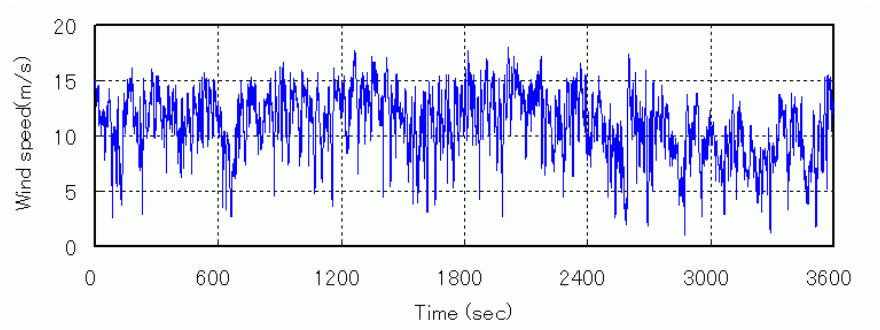
Figure 5 Measured wind data at WTG site